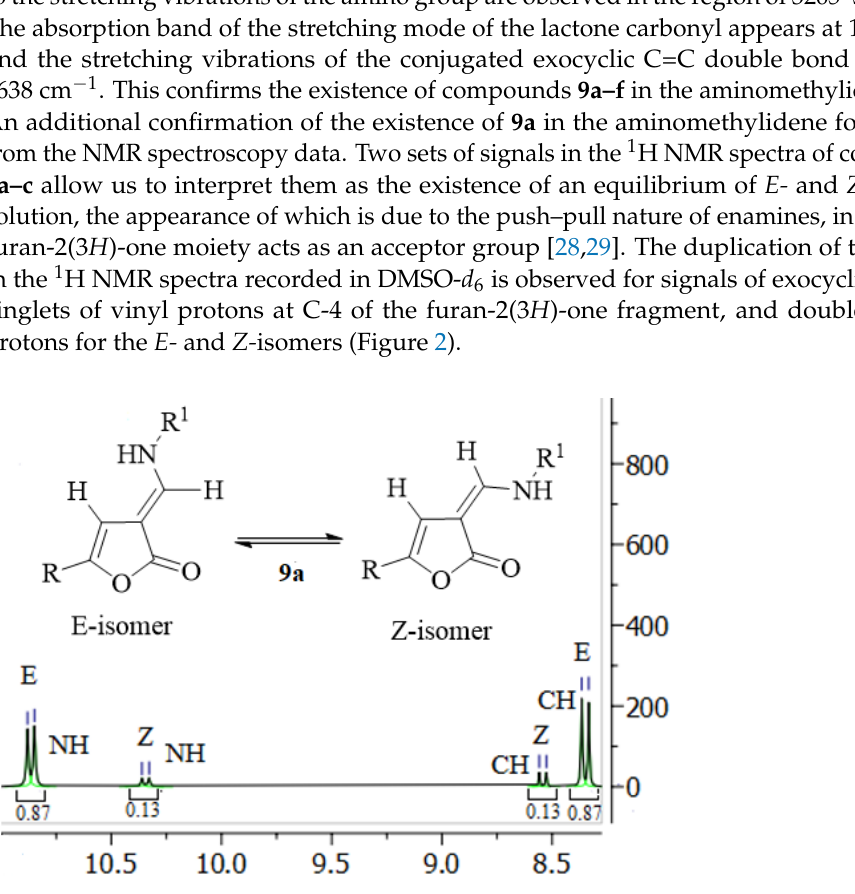
Figure 2. Fragment of the 1 H NMR spectrum of 5-(4-chlorophenyl)-3-(pyridin-2-ylamino)methylidenefuran-2(3 H )-one 9a , showing signals of Z - and E -forms.